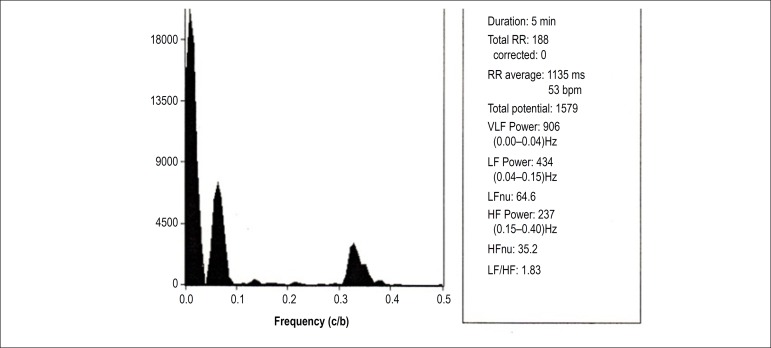
Spectral analysis of a male patient (67 years of age) with
orthostatic hypotension in supine position. RR: number of QRS in
sinus rhythm; VLF: very low frequency; LF: low frequency; HF: high
frequency; HFnu: HF normalized unit.